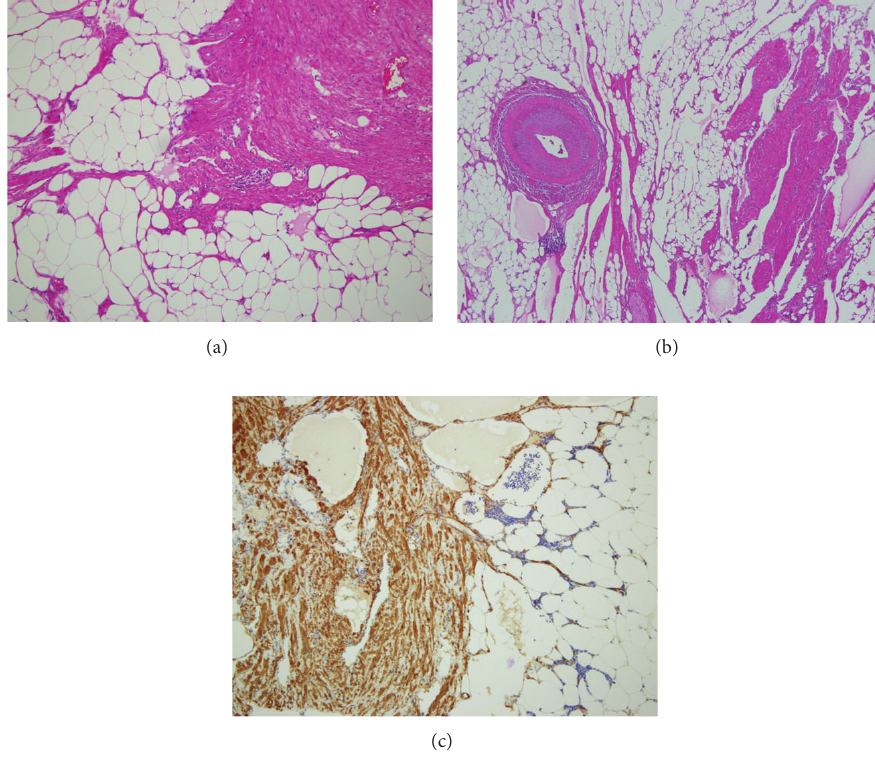
Figure 3: Microscopic findings of the tumor. (a) The tumor shows admixture of smooth muscle and mature adipocytes. (b) Widely dilated vessels and a thick wall vessel are seen within the tumor. (c) Smooth muscle cells are immunoreactive with alpha-smooth muscle